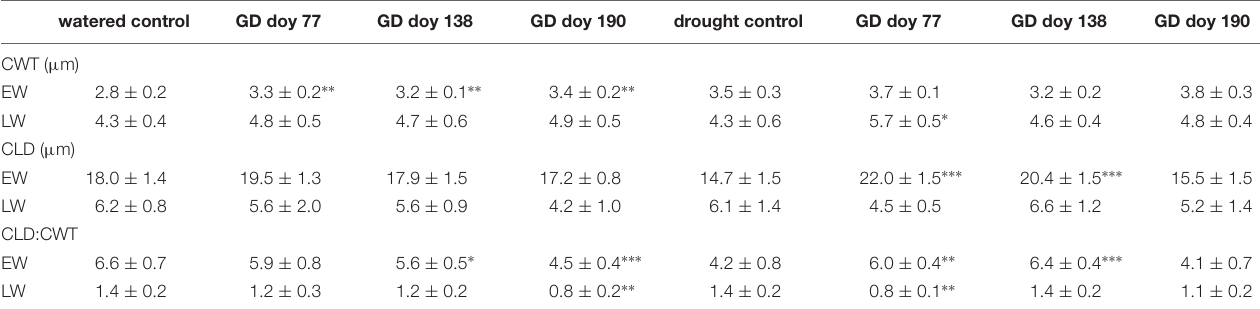
TABLE 1 | Wood anatomical parameters of earlywood (EW) and latewood (LW) in coarse roots in controls and watered and drought stressed girdled trees (CWT = cell wall thickness; CLD = cell lumen